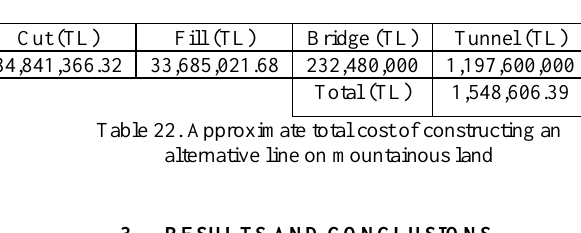
Table 21. Total length of engineering structures required for the construction of an alternative line on mountainous land